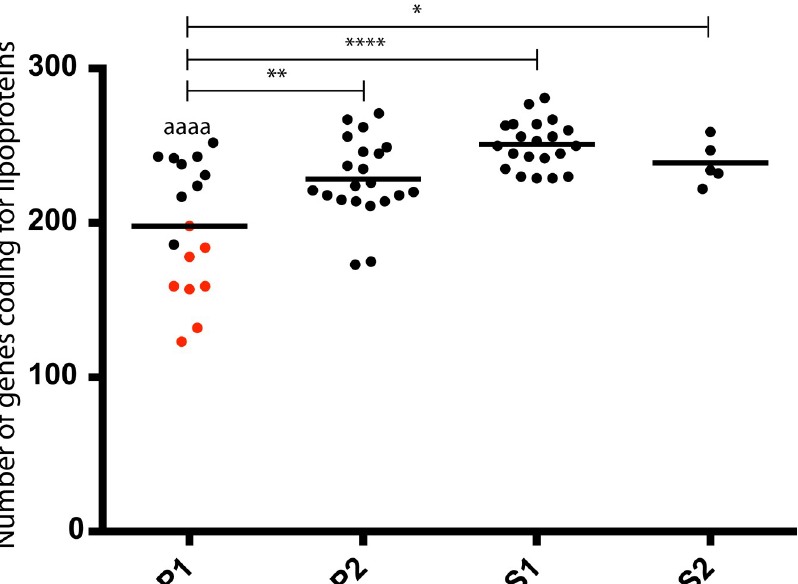
Fig 6. Distribution of genes encoding lipoproteins. The " � " represent the level of significance between the different groups: � P � 0.05, �� P � 0.01, ��� P � 0.001, and ���� P � 0.0001. The level of significance between the two pathogenic P1 groups (before and after node 1) is represented by the same code, but for the sake of clarity the symbol is "a". The points representing the genome-specific values of the species that diverged after node 1 in Fig 1 ( L. interrogans, L. kirschneri, L. noguchii, L. santarosai, L. mayottensis, L. borgpetersenii, L. alexanderi and L. weilii ) are in